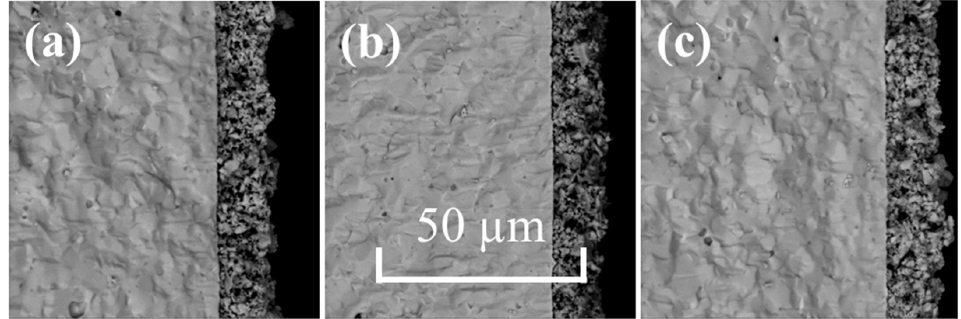
Figure 2. Microphotographs of symmetric configuration cells after electrode sintering of compositions: